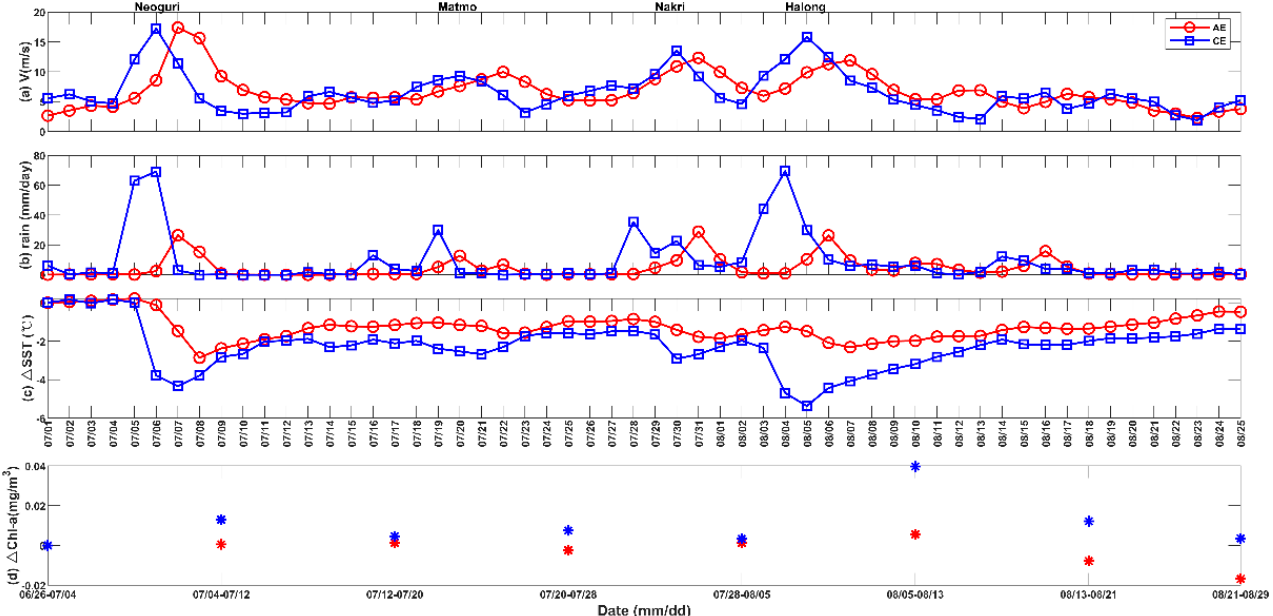
Figure 4. Time series of the ( a ) daily sea surface wind speed, ( b ) daily rainfall, ( c ) daily SST anomaly and ( d ) weekly chl-a anomaly in AE (red) and CE (blue).